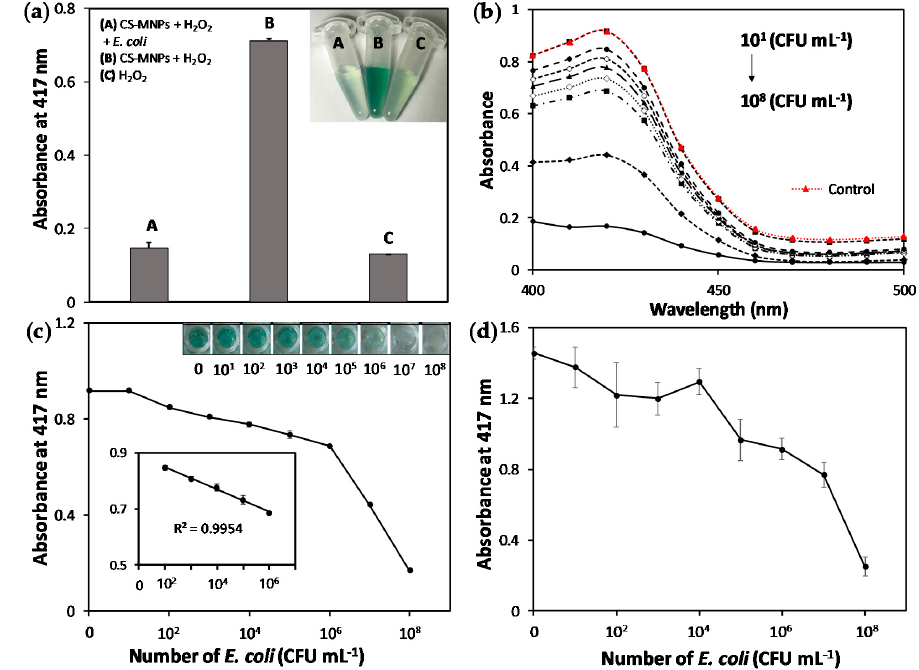
Figure 4. ( a ) Absorption intensity of the reaction leading to ABTS oxidation using CS-MNPs in the presence or absence of E. coli (10 8 CFU mL − 1 ). Real photograph of the reaction solution is shown in